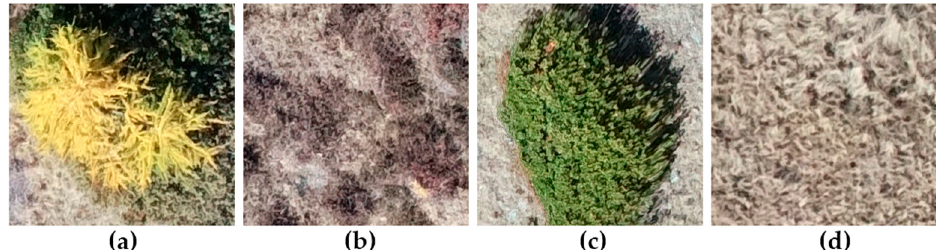
Figure 2. Vegetation classes identified in the study area and used for classification: larch trees ( a ), brownish shrubs ( b ), greenish shrubs ( c ) and grassland ( d ). Portions of the drone images acquired in October 2018.